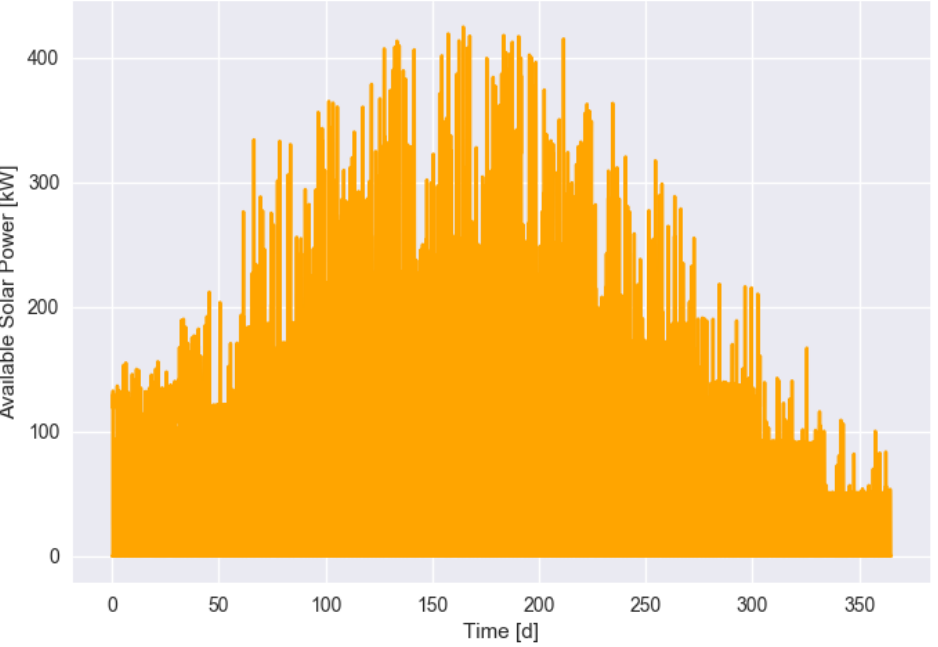
Figure 1. PV system output during the